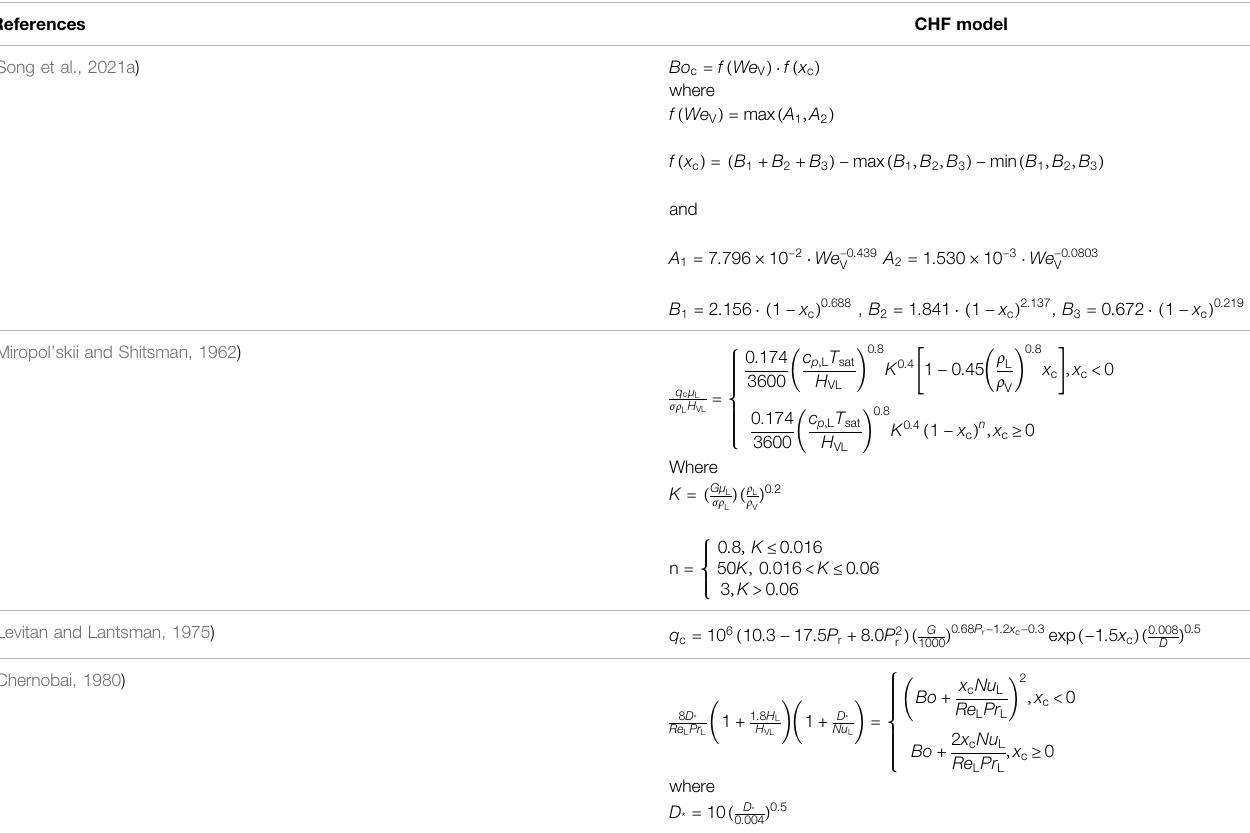
TABLE 2 | CHF prediction models for high-pressure